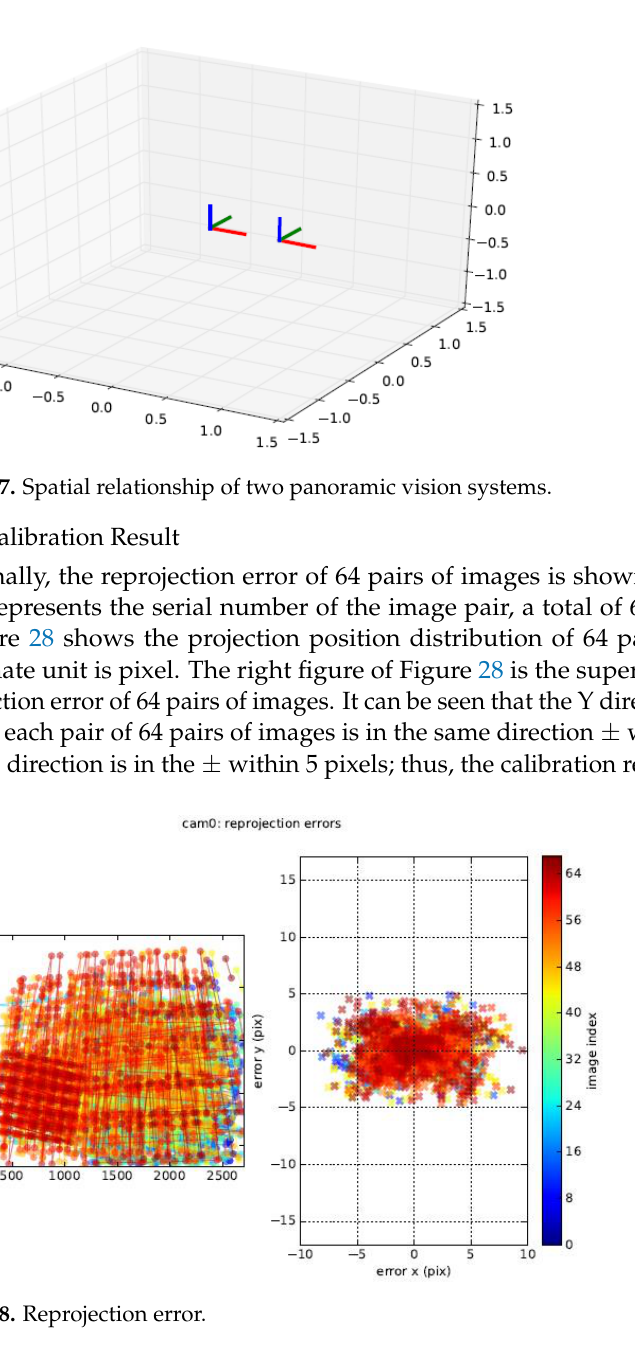
Figure 29. Unmanned systems experimental platform.